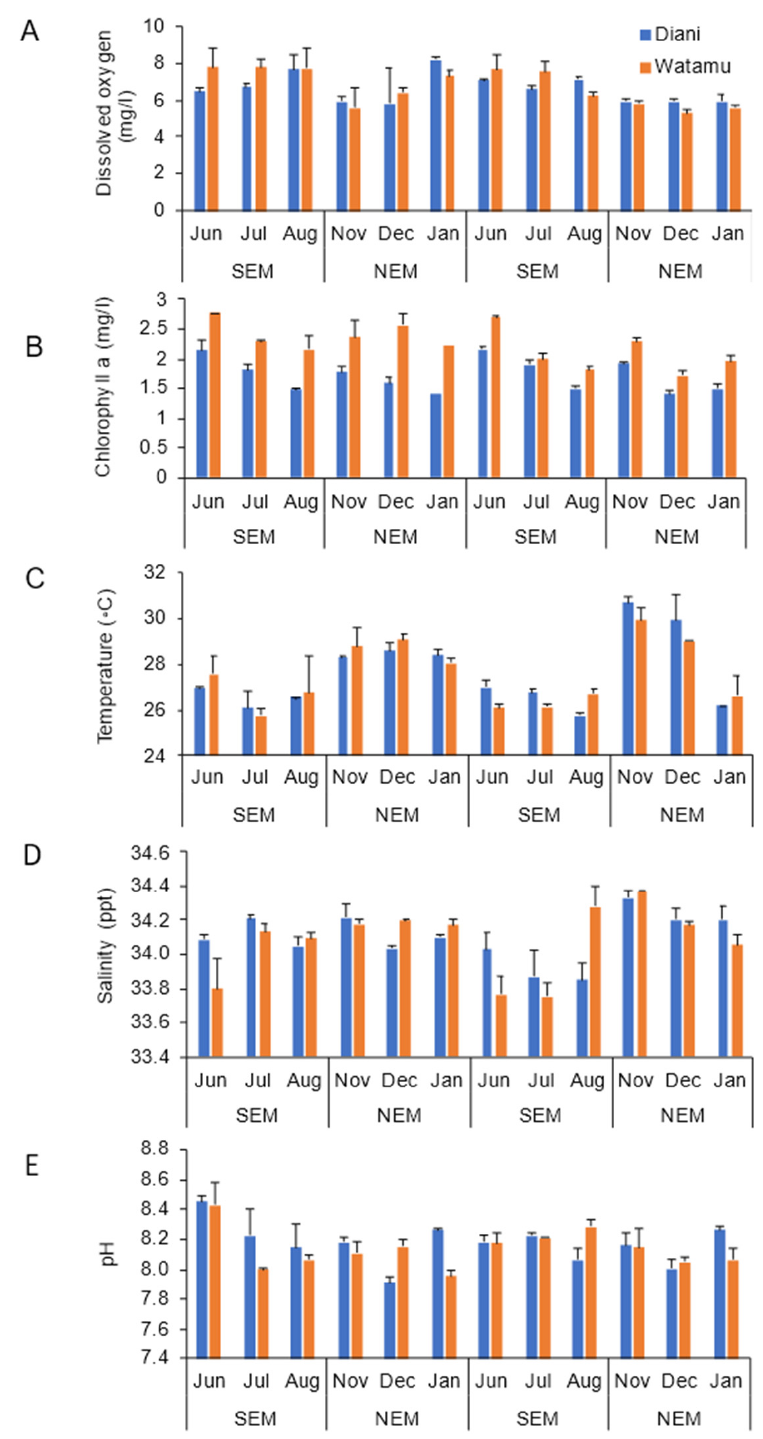
Figure 2. ( A – E ). Variation in dissolved oxygen ( A ), chlorophyll -a ( B ), temperature ( C ), salinity ( D ) and pH ( E ) in Watamu and Diani, Kenya (±SE) during June to December 2019, January to December